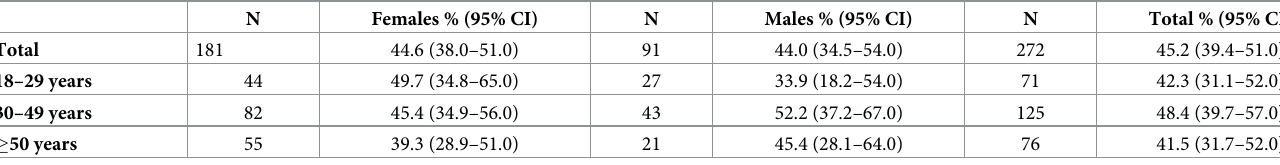
Table 2. Prevalence of individuals infected by the SARS–CoV–2, stratified by sex and age.